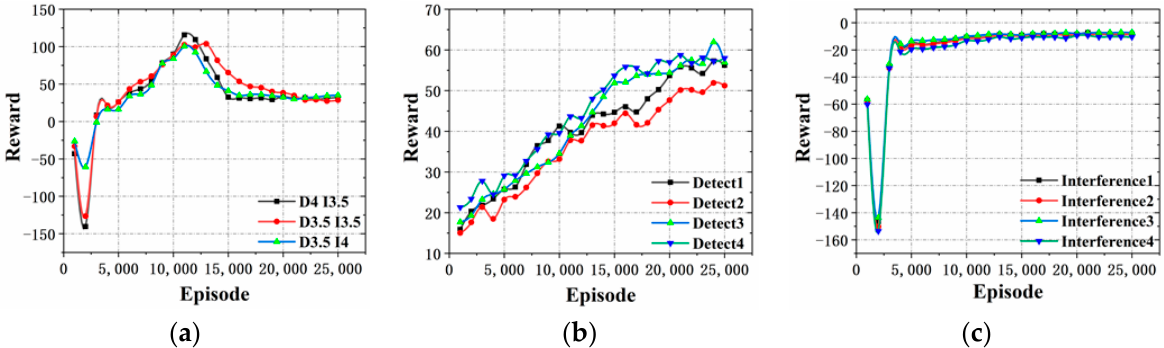
Figure 13. Experimental reward function curves for multi-agent barrier-covert confrontation environment: ( a ) reward function curves for the blue detection multi-agent and the red interference multi-agent with different acceleration parameters; ( b ) reward function plot for the blue detection agents; ( c ) reward function curves for the red interference agents.